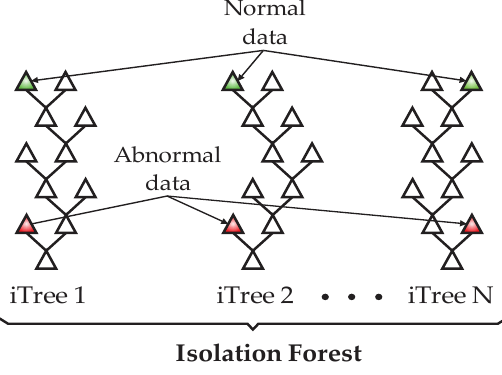
Figure 2. Typical structures of the isolation forest.